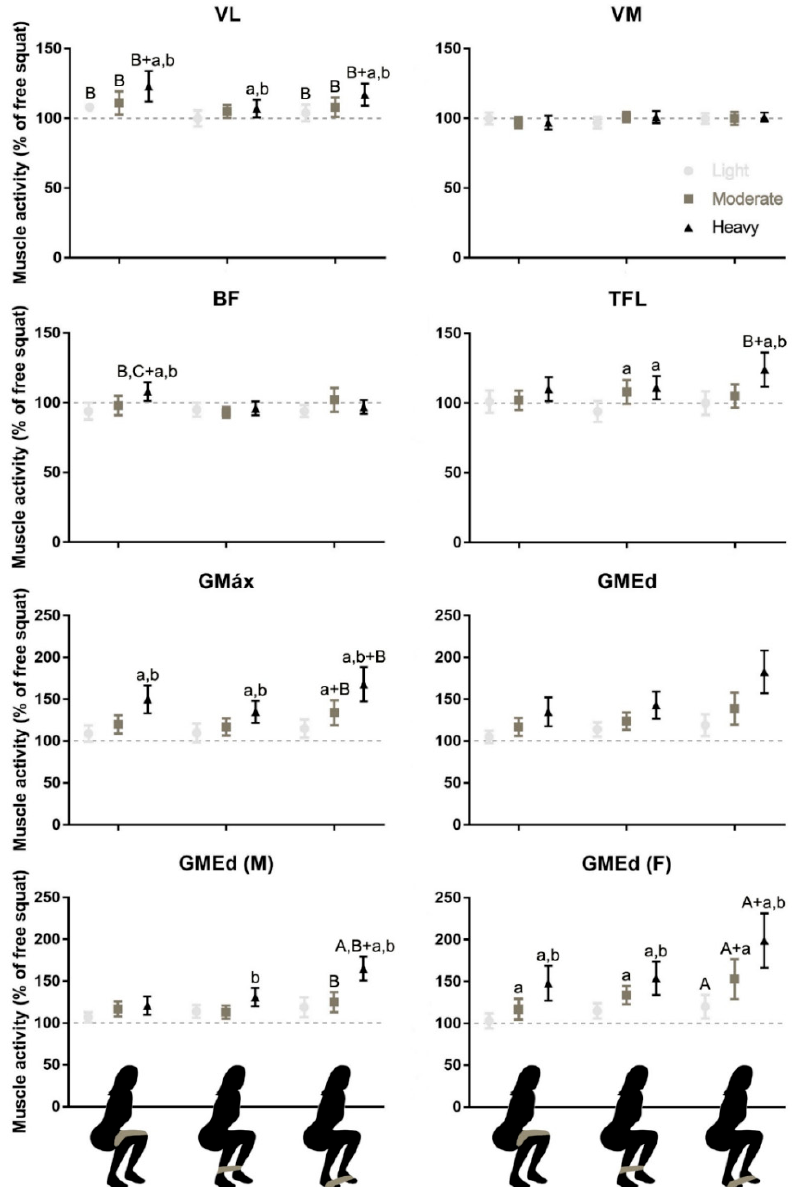
Figure 1. Estimated mean and confidence intervals of the myoelectric activity of vastus medialis (VM), vastus lateralis (VL), biceps femoris (BF), gluteus maximus (GMAX), gluteus medius (GMED), and tensor fascia late (TFL) during squatting for all combinations of band stiffness (light, moderate, and heavy) and band position (illustrated at the bottom) tested in this study. Myoelectric activity measured for the entire squat cycle was normalized to the myoelectric activity obtained in squatting without elastic resistance (100%). Interactions between sex and band stiffness were observed for the GMED, so inferential results are shown for men (M) and women (W) separately. Interactions between the effects of band position and stiffness were observed for the GMED (M), GMAX, TFL and BF muscles. Dashed line indicates the myoelectric activity during the free squat with no band. Small letters (a, b) indicate greater, for a given position, myoelectric activity compared to the light, moderate, and heavy band stiffness, respectively. Capital letters (A, B, C) indicate, for a given stiffness, greater myoelectric activity compared to the band around the thigh, the lower leg, and the forefeet respectively.